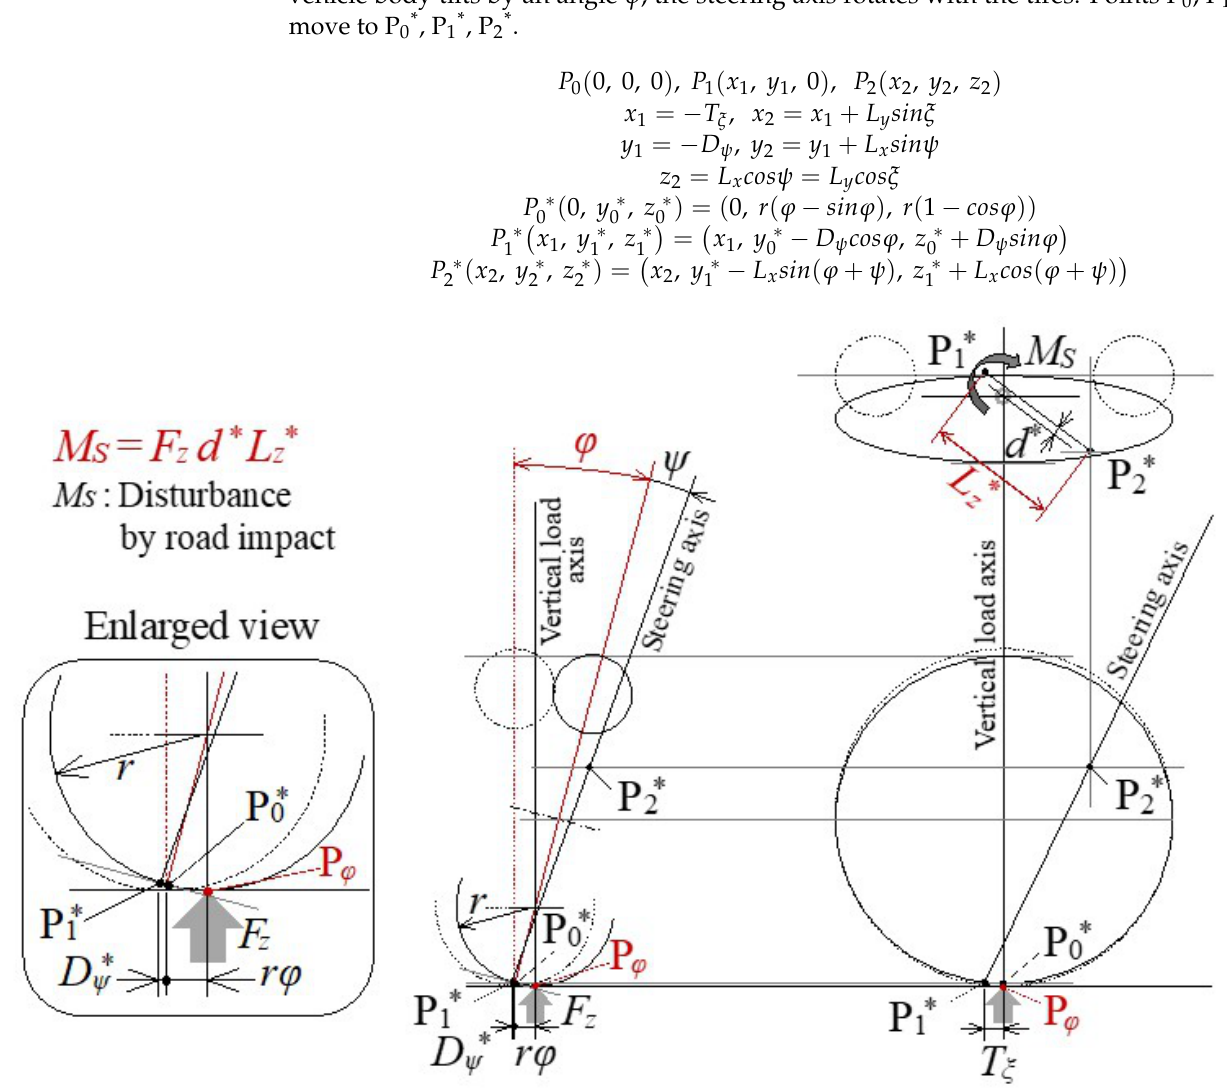
Figure 11. Steering axis on tilted condition. The * shows when the tire is tilted